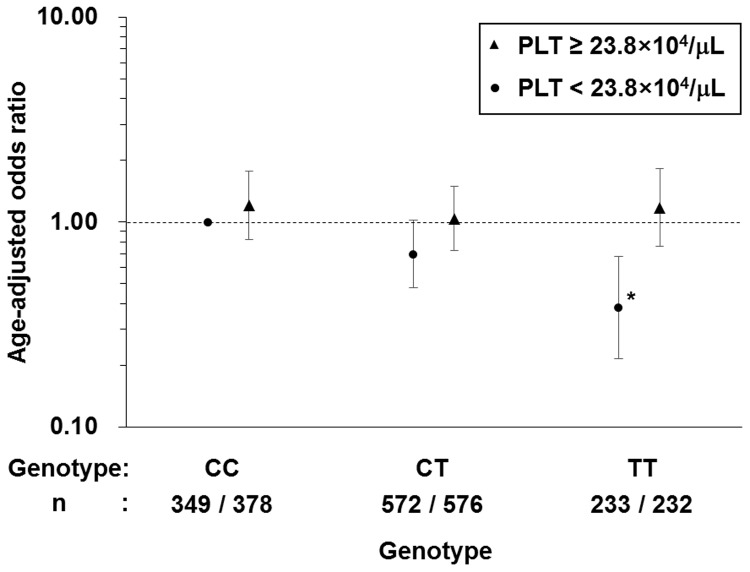
Age-adjusted ORs for MetS in platelet ≥ 23.8×104/μL and < 23.8×104/μL with different rs7965413 genotypes The vertical bars represent the 95% CIs.The horizontal dashed line indicates the null value (odds ratio (OR) = 1.0). OR represents risk of MetS development in the group with each genotype of rs7965413 and each dichotomous platelet count compared with the group with the CC genotype and PLT count of < 23.8×104/μL. *: P < 0.05.